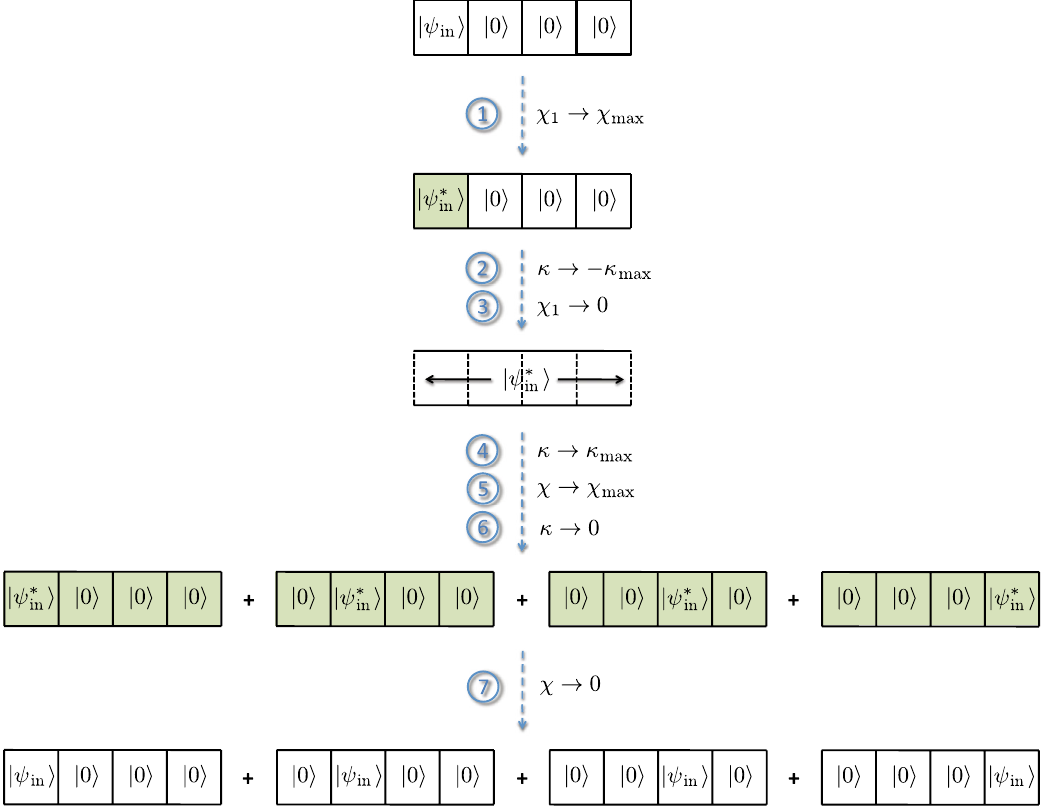
FIG. 6. Illustration of the entanglement protocol for the case of four resonators. Square boxes denote single resonators, solid black lines shared between square boxes denote inter-resonator coupling ( (cid:2) ) off, dashed black lines denote coupling on, green shading denotes resonator nonlinearity ( (cid:1) ) on, white shading denotes nonlinearity off, periodic boundary conditions are implied, and dashed P i ¼ e (cid:4) i(cid:5) n ð t Þ C j n i denotes a version of j c i with modifications to the blue arrows denote steps of the entanglement protocol. j c (cid:11) n n in in phases of each number component. A detailed account of the process in terms of the individual j n i is provided in the main text. In the first step, the nonlinearity is turned on for the first site only, which creates an energy barrier against which (cid:2) may be turned on i may then adiabatically transition to the superfluid state by adiabatically turning off (cid:1) (step 3). At this adiabatically in step 2. j c (cid:11) 1 in i is in the highest excited superfluid state because of the lattice asymmetry introduced in step 1 and the sign of (cid:2) . After point, j c (cid:11) in i is in the superfluid ground state. Step 5 ( (cid:1) is adiabatically turned on across the whole lattice) and switching the sign of (cid:2) in step 4, j c (cid:11) in step 6 ( (cid:2) is adiabatically turned off) induce the ABH phase transition and make (cid:4) ¼ 0 , so that the perfect W state is achieved, with i nonlocally superposed in each resonator. Finally, turning off the resonator nonlinearities (cid:1) (step 7) restores the lattice to an array j c (cid:11) in of uncoupled linear resonators that now contains the entangled state. With correct timing of the last step, (cid:5) n ð T Þ ¼ 0 ( T is the total time i is restored to j c i of the protocol) and j c (cid:11) in in